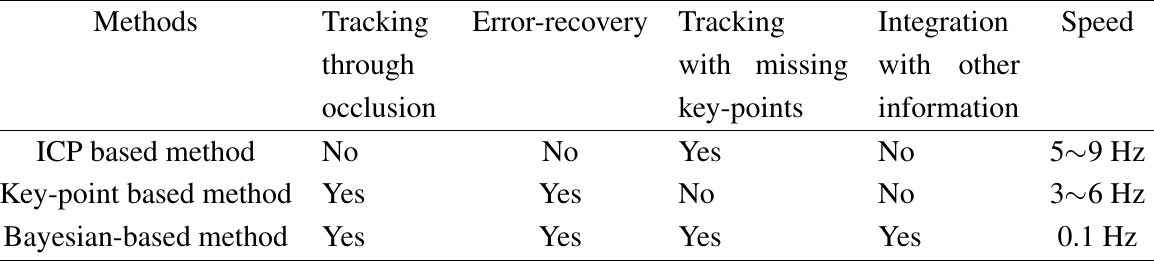
Table 1. Comparison between various human pose tracking approaches.